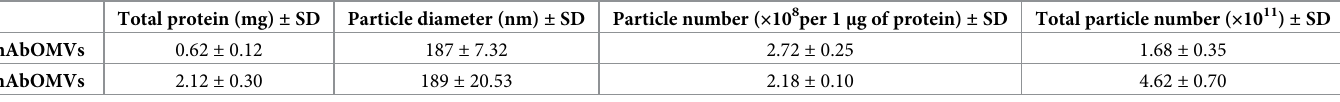
Table 1. Total protein, particle diameter and particle number of nAbOMVs and hAbOMVs obtained from 4.8 L of A . baumannii ATCC19606 culture supernatants (n = 3). Total protein (mg) ±